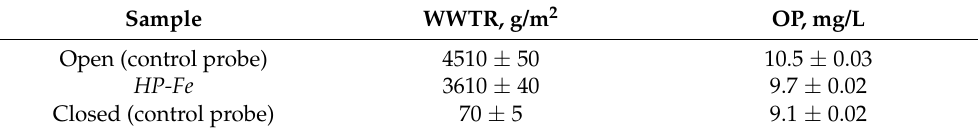
Table 2. Material permeability.